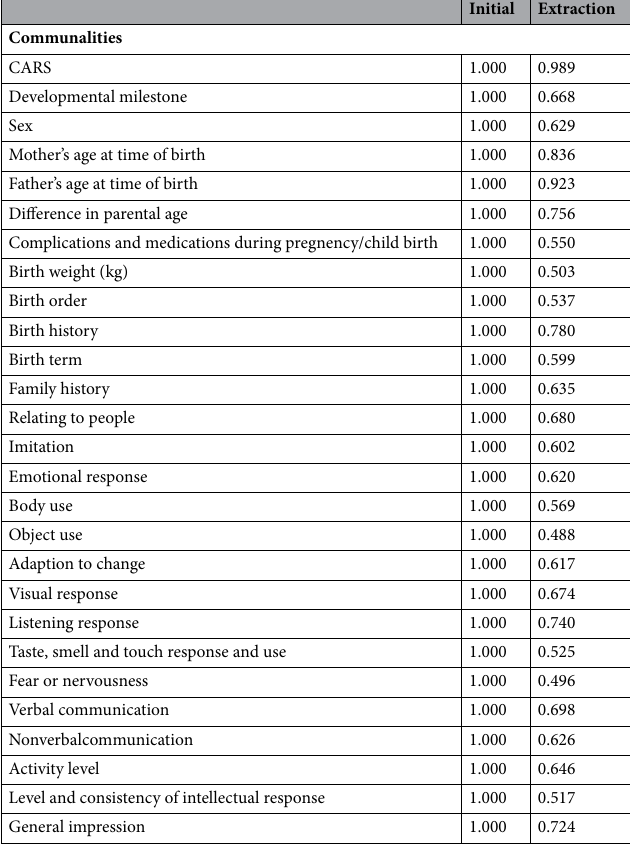
Table 1. Communalities of the variables obtained from the Varimax rotation model. Extraction method: principal component